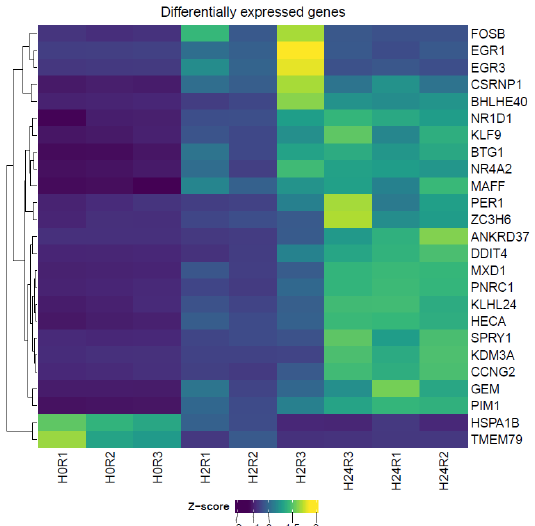
Figure 2. Z-score of normalized CPM values of differentially expressed genes. Genes with p-adjusted value < 0.05 and FC > 1.5 were selected and plotted using ComplexHeatmap package (Gu et al., 2016). H0—normoxic cells; H1, H2, and H24—cells incubated for 1 h, 2 h, and 24 h under hypoxic conditions, respectively.